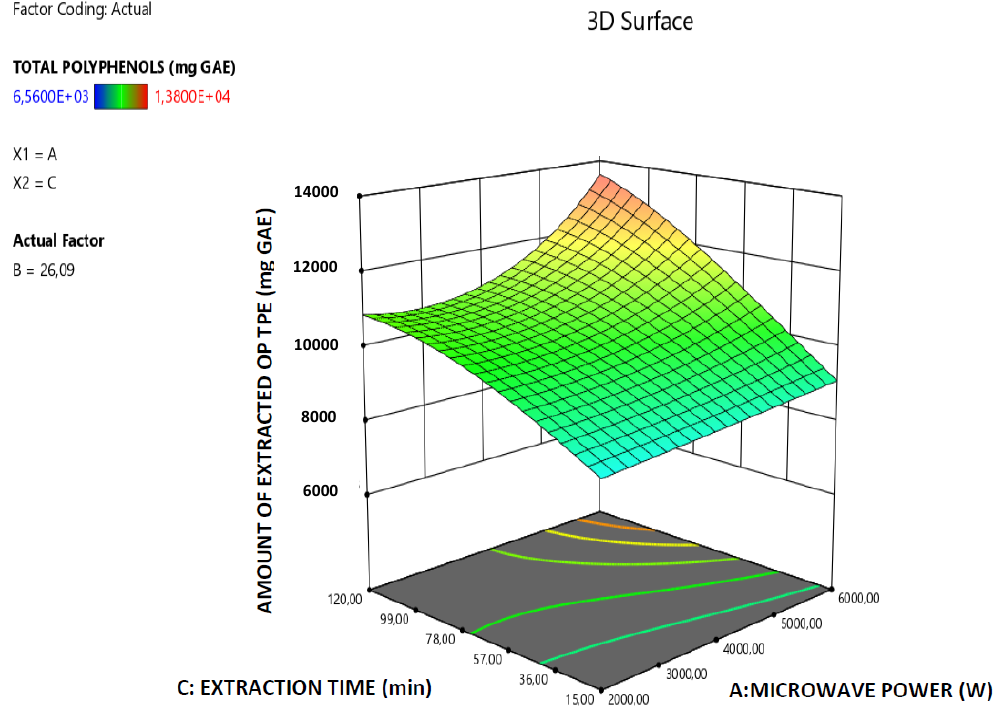
Figure 3. Response surface plot of the amount of extracted total OP polyphenols (TPE in mg GAE) A × C interaction (A: Microwave Power (W); C: extraction time